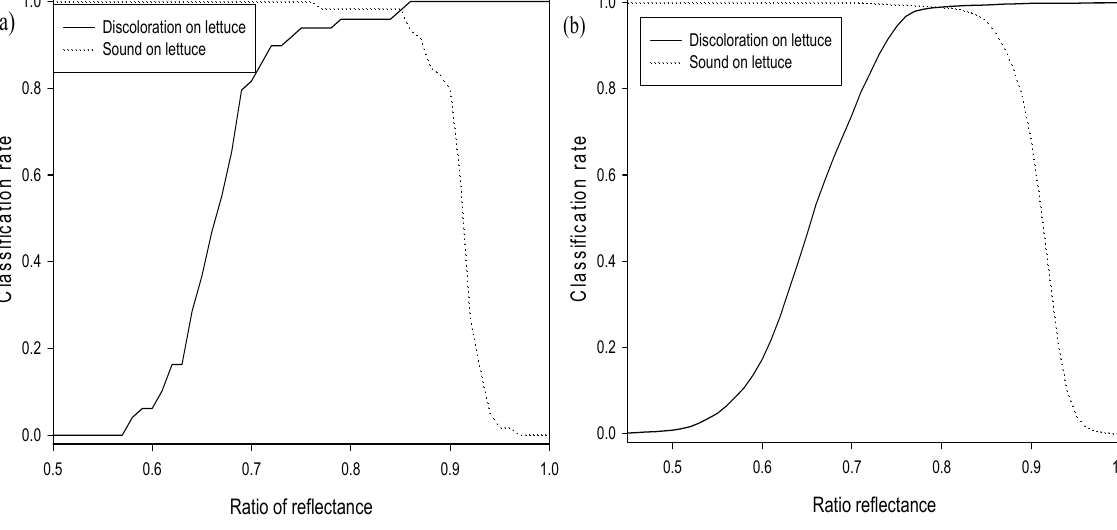
Figure 8. Classification rate results for sound and discolored areas on both adaxial and abaxial surfaces using the ratio of two wavebands (R 552/701 ): ( a ) average spectrum and ( b ) pixel